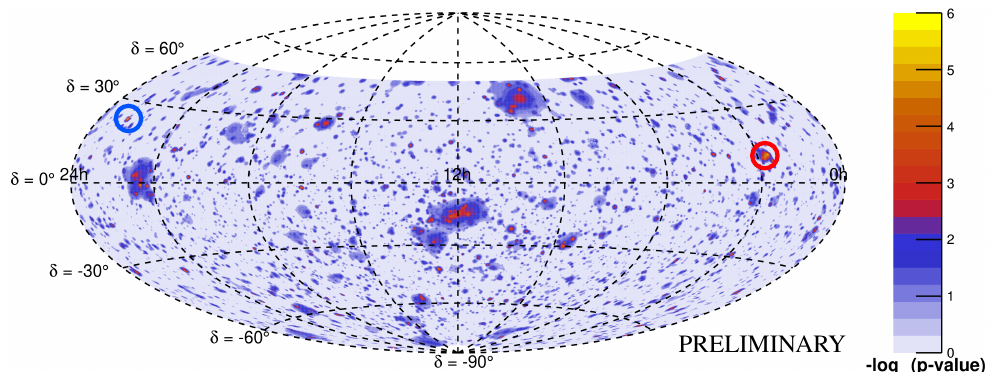
Figure 3. Sky map in equatorial coordinates of pre-trial p -values for point-like sources of the ANTARES visible sky (declination, δ , in degrees; right ascension in hours). The location of the most (second most) significant cluster of the full-sky search is indicated by the red (blue) circle. Figure adapted from Ref.